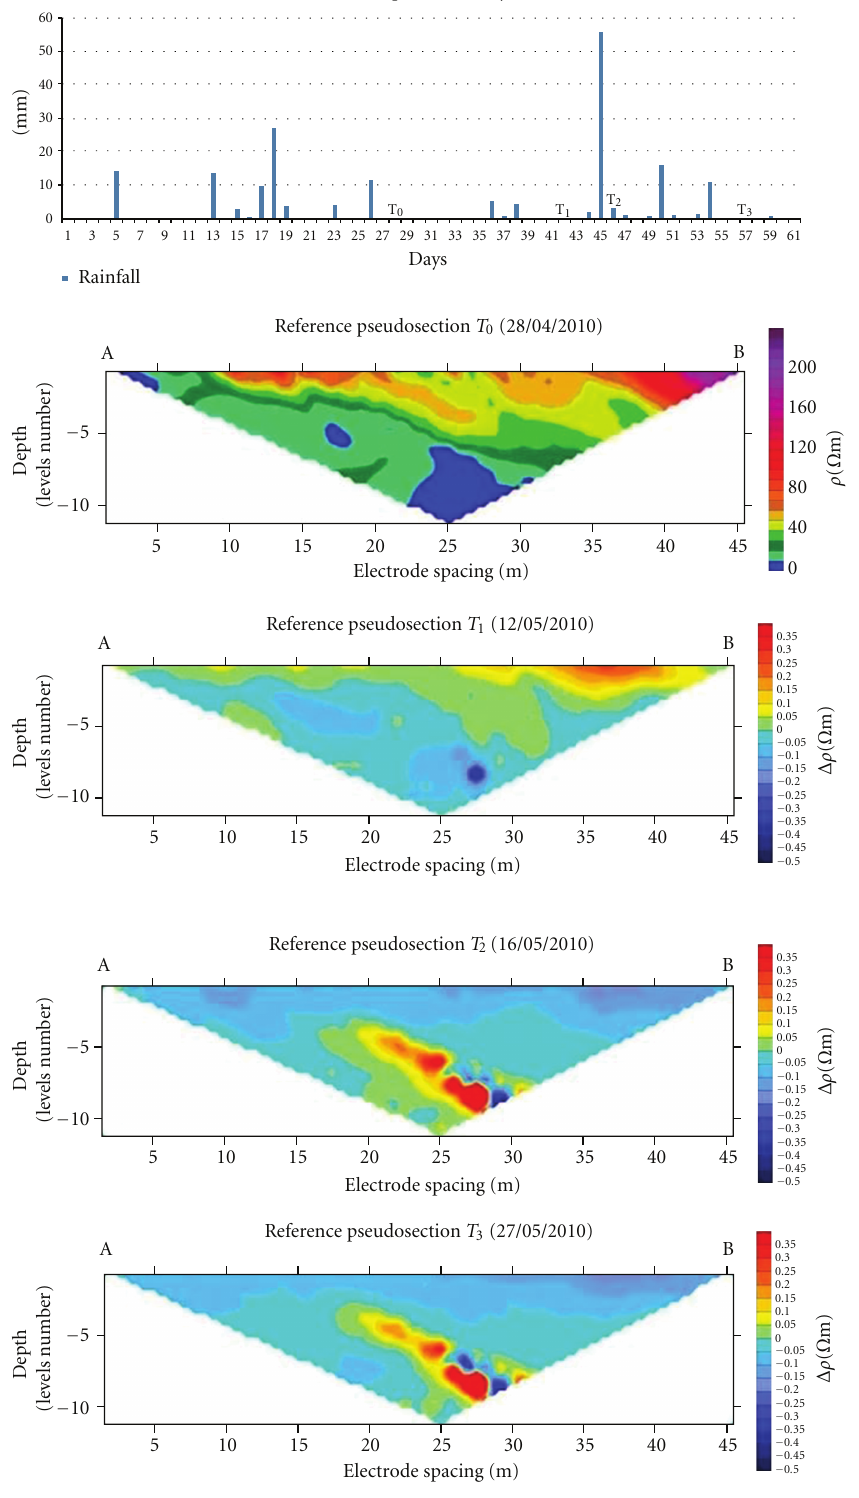
Figure 13: Resistivity di ff erences calculated with respect to a fixed time T 0 (28/04/2010). Di ff erences are referred to three days of May 2010, chosen after intense